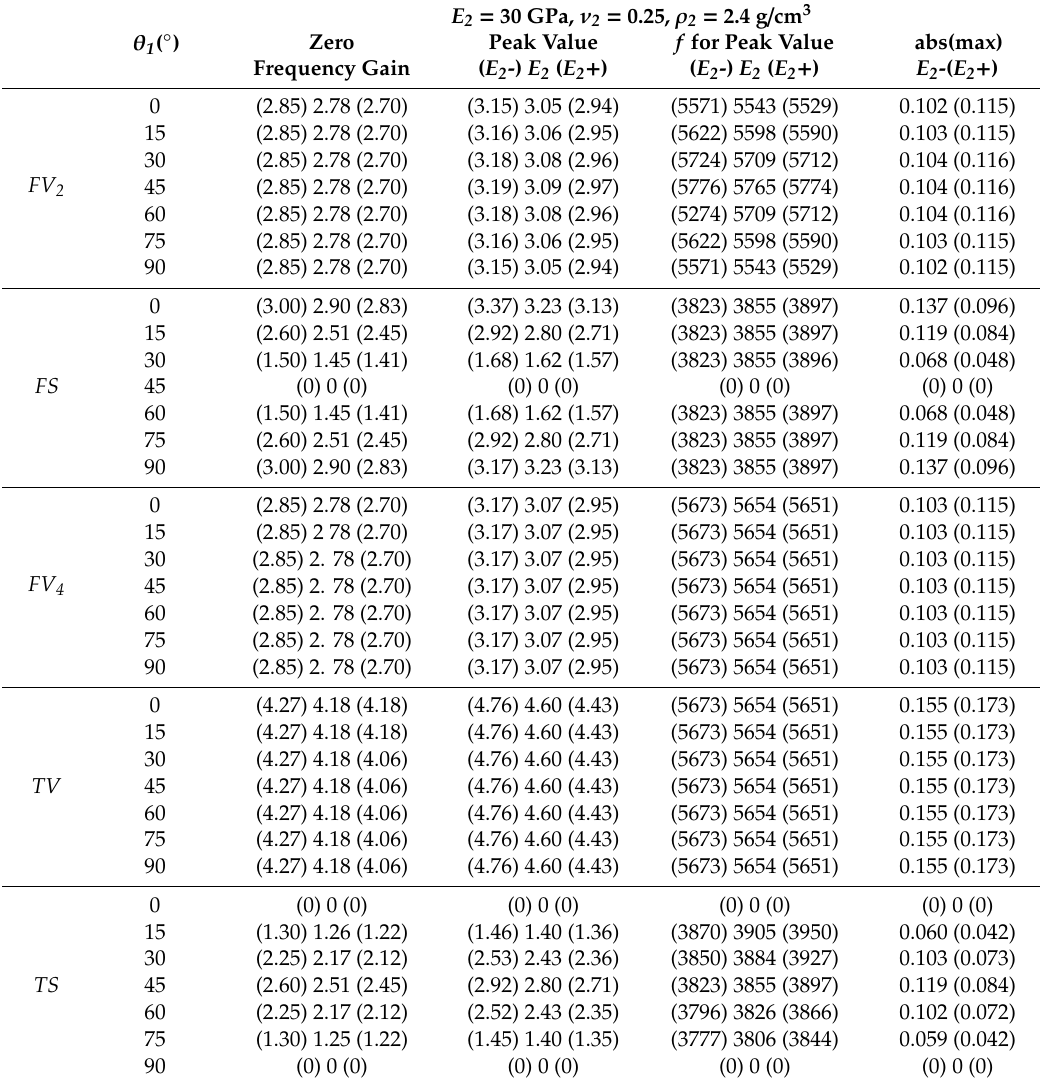
Table 2. Influence of Young’s modulus of the expansive grout on the theoretical amplitude spectrum of gauge combinations FV 2 , FV 4 , FS, TV and TS for the incident P